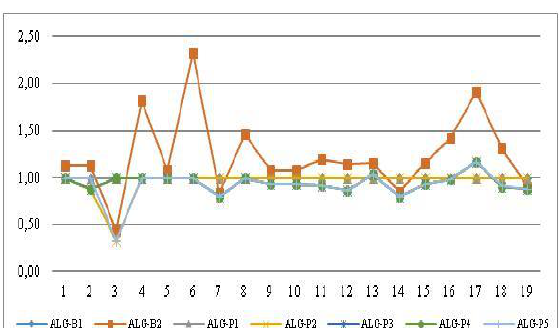
Figure 6. Relative comparison of the solution steps The second comparison of the obtained solutions is the solution times. The solution times of the methods for different datasets are shown in Table 5. On the other hand, the relative comparison is made according to the ALG-B1 method in Table 6. When the average solution times are taken into consideration, it is seen that the proposed methods provide better solutions in shorter times. The solution time comparison is shown in Figure